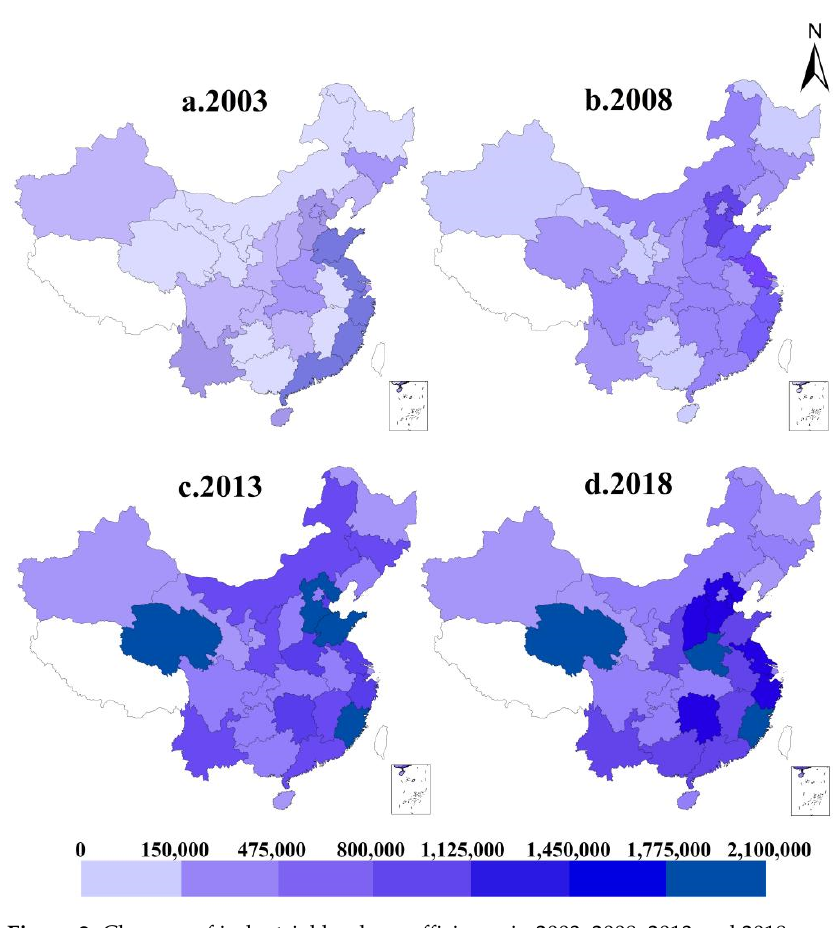
Figure 2. Changes of industrial land use efficiency in 2003, 2008, 2013 and 2018. Table 2. Tests for threshold effect and threshold value estimation of the eastern